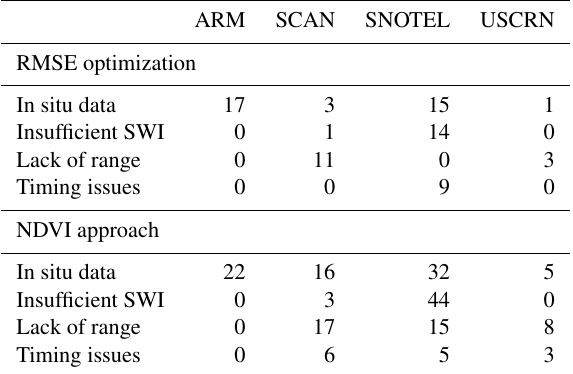
Table 2. Number of poor-performing (NS < 1.00) outliers for all four satellite